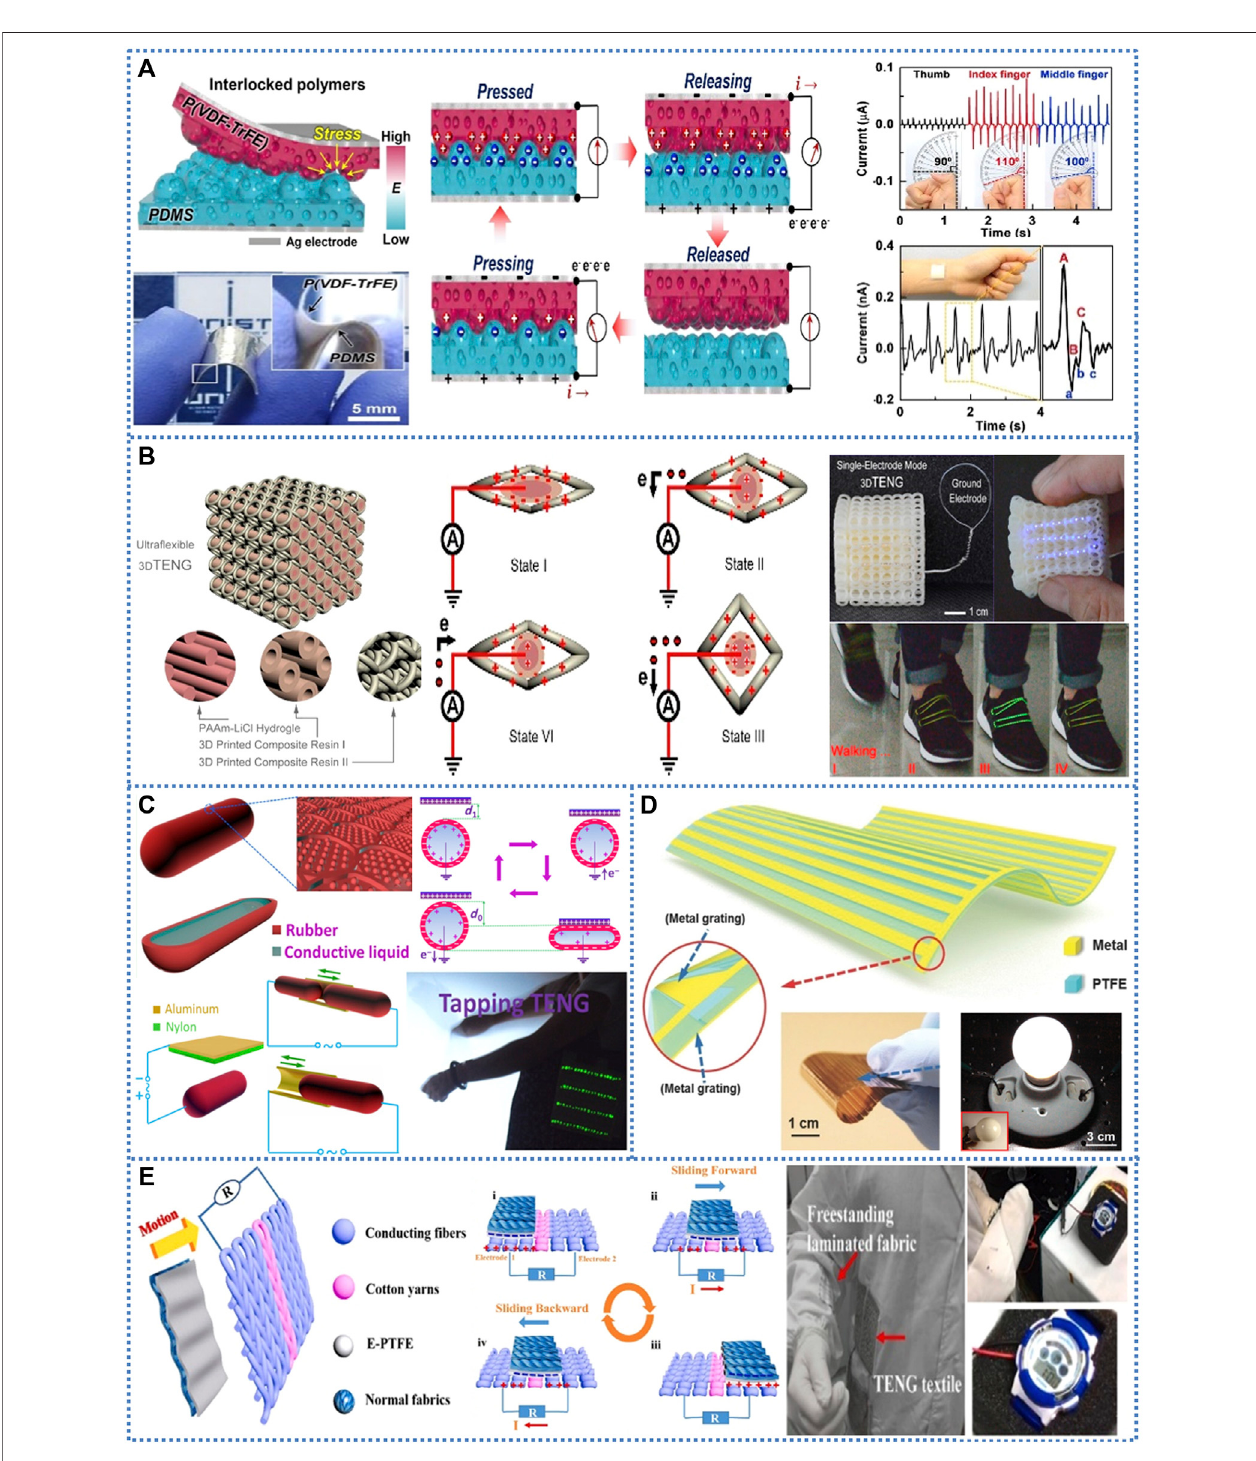
FIGURE 1 | Various structures of soft TENGs. (A) Schematic of vertical contact-separation mode soft TENG with the interlocked micro-ridge structure. (B) The con fi guration of a single-electrode mode soft TENG with three-dimensional structure. (C) The single-electrode mode soft TENG with package structure. (D) The micro- grating based soft TENG in lateral sliding mode. (E) The wearable textile-based soft TENG in freestanding triboelectric-layer mode (Song et al., 2021).